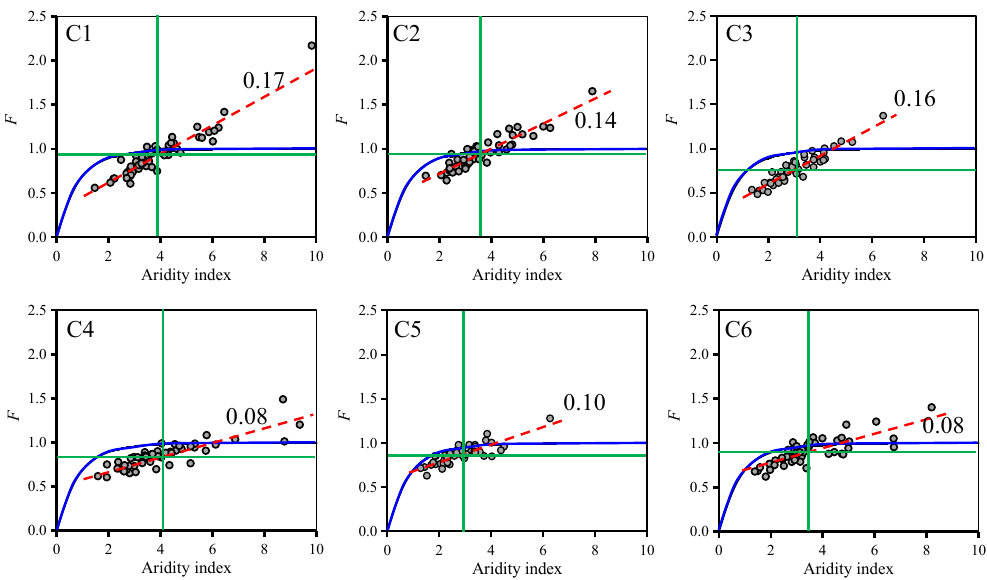
Figure 7. Plots of the annual F − ϕ data in the study catchments in the standard Budyko space for the 1957–2010 period. The actual evapotranspiration is estimated using the “natural” models. The solid blue line is the original Budyko curve determined with Eq. (2). The dashed red lines are the linear regression curves of the data points with the slope data shown nearby. The intersection point of the green lines denotes the mean annual